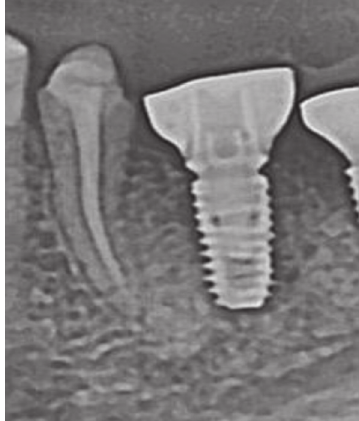
Figure 9: Checking the fit of the provisional composite